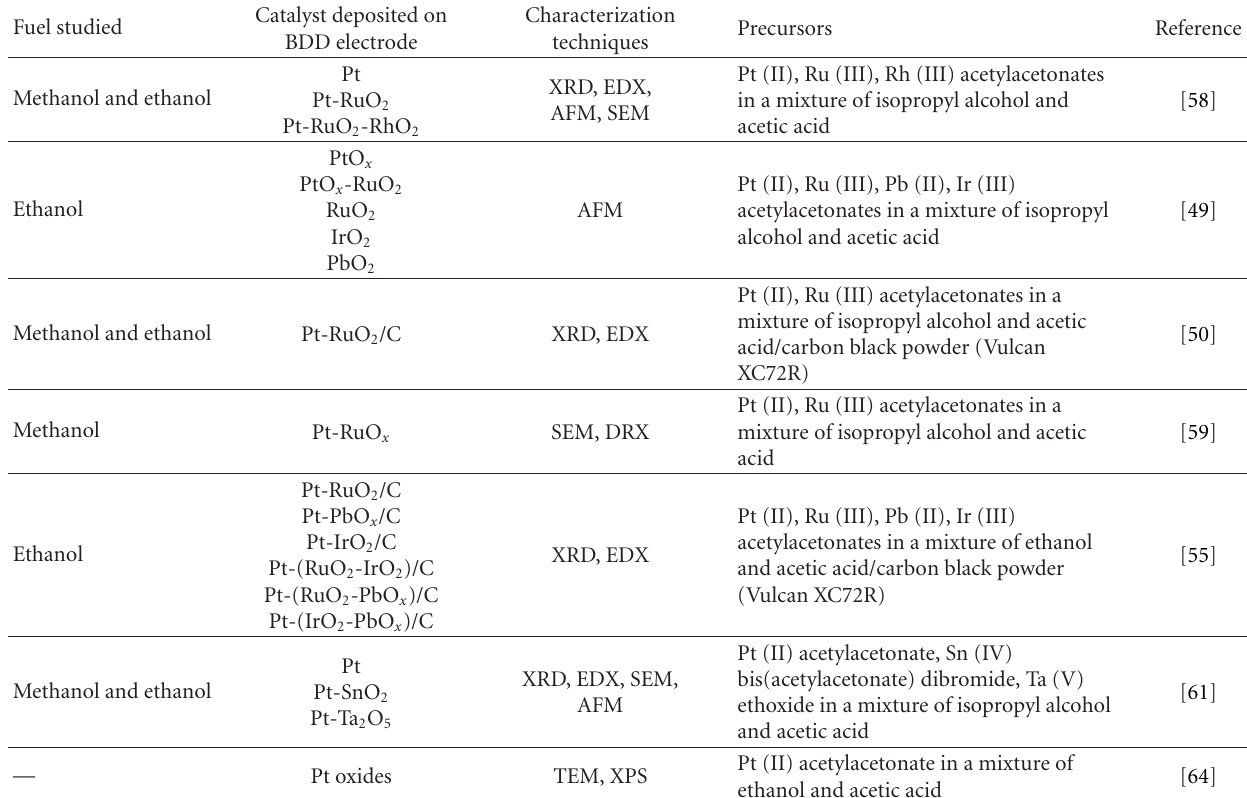
Table 2: Catalysts or composite catalysts on BDD support synthesized by the sol-gel